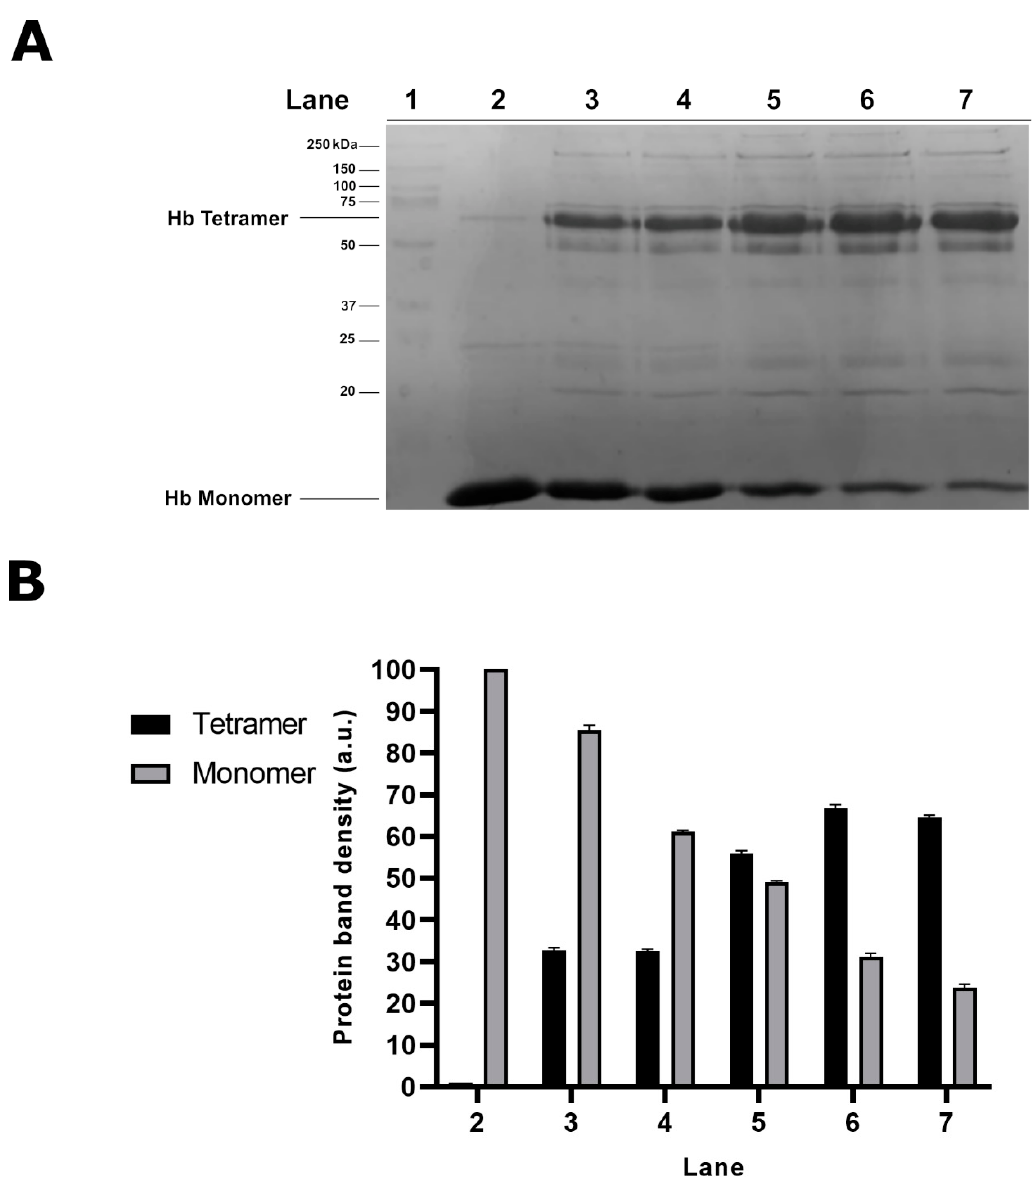
Figure 1. Sodium dodecyl sulfate-polyacrylamide gel electrophoresis (SDS-PAGE) analysis of the cytosolic fraction from mercury (Hg)-treated human red blood cell (RBC). Intact RBC were exposed in vitro for 4 h to different concentrations of mercuric chloride (HgCl 2 ) and the cytosolic fractions analysed by SDS-PAGE. ( A ) Electrophoretic profile of the cytosolic fractions from untreated RBC (lane 2) and cells exposed to 60, 40, 20, 10 and 1 µ M HgCl 2 (lanes 3–7, respectively). Molecular weight (MW) markers (lane 1). ( B ) Densitometric analysis of the 16 and 64 kDa protein bands. The values shown are relative to n = 5 repeats.